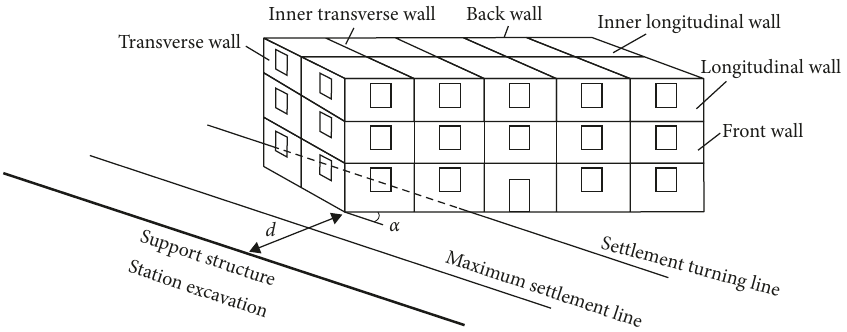
Figure 7: Building around the station